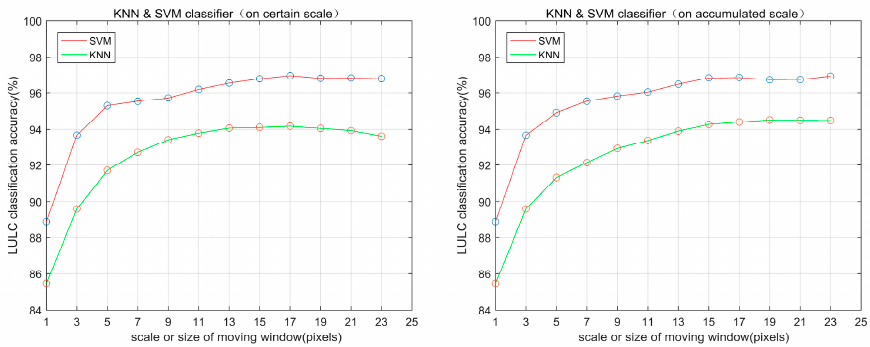
Figure 5. Overall accuracies of the LULC classification with different feature set configurations in the SVM and KNN classifiers.